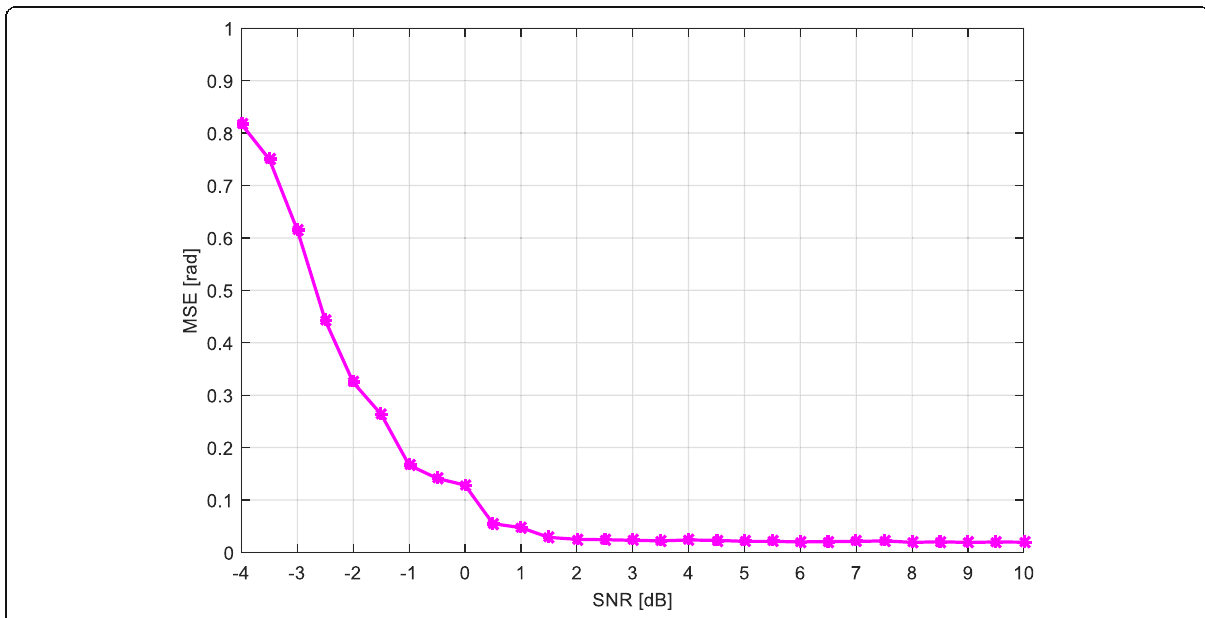
Fig. 20 MSE vs. SNR in a practical noisy environment